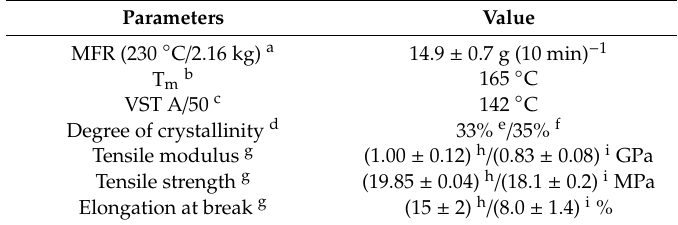
Table 1. Properties of the medically certified polypropylene used to print protective equipment.